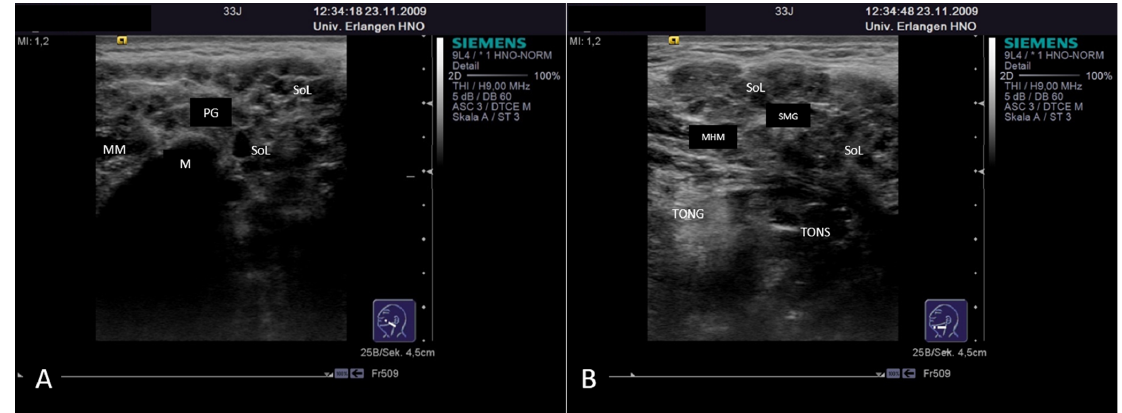
Figure 13. ( A , B ): Ultrasound findings at the advanced stage of M. Sjögren in the left GP ( A ) and left SMG ( B ). The paren- chyma is markedly heterogeneous and replaced by hypoechoic to anechoic spot-like formations as less parenchyma is recognizable. Hypoechoic areas appear more solid and may correspond to an infiltration of lymphatic cells, anechoic to sialectatic ducts after atrophy of the acinic cells. The glands are enlarged. Abbreviations: PG, parotid gland; SMG, sub- mandibular gland; M, mandible; MM, masseter muscle; MHM, mylohyoid muscle; TONG, tongue; TONS, tonsil; SoL, space-occupying lesion.